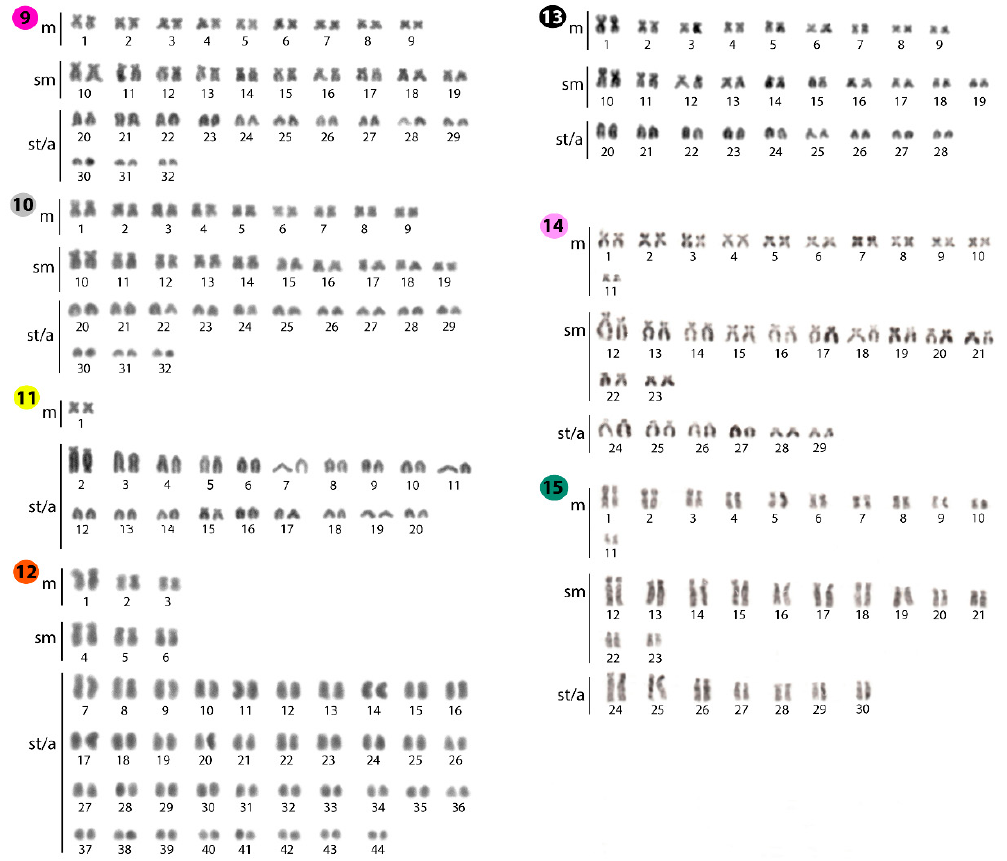
Figure 2. Karyotypes of Phalacronotus apogon ( 9 ); Phalacronotus bleekeri ( 10 ); Silurichthys phaiosoma ( 11 ); Wallago attu ( 12 ); Wallago micropogon ( 13 ); Silurus aristotelis ( 14 ); and Silurus glanis ( 15 ) arranged following Giemsa-staining. Bar = 5 µm.